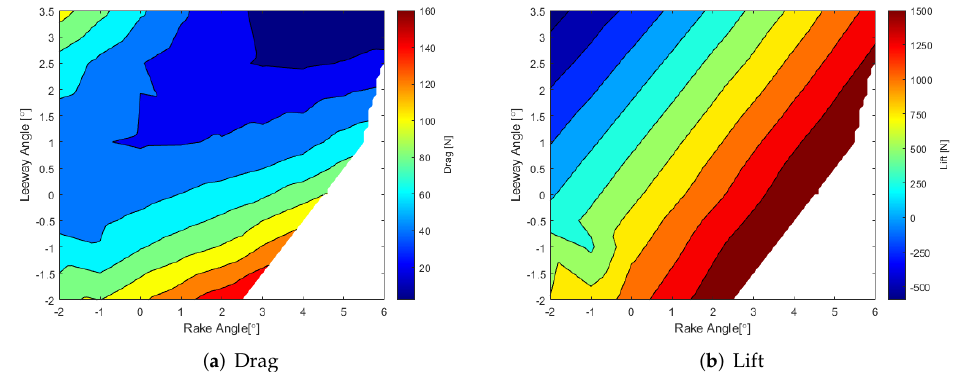
Figure 27. Lift and drag for the investigated range of leeway and rake angles and flow speed of 5 m/s.